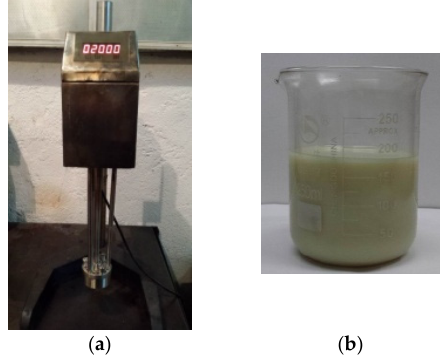
Figure 3. ( a ) The stirrer and ( b ) the water emulsified HFO ‐ L.